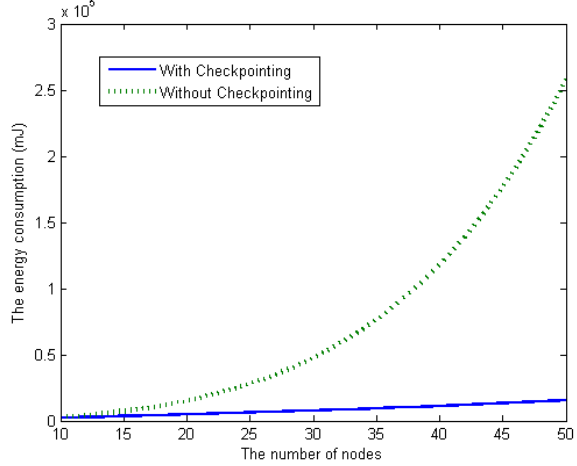
Figure 10. Comparison of the energy consumption